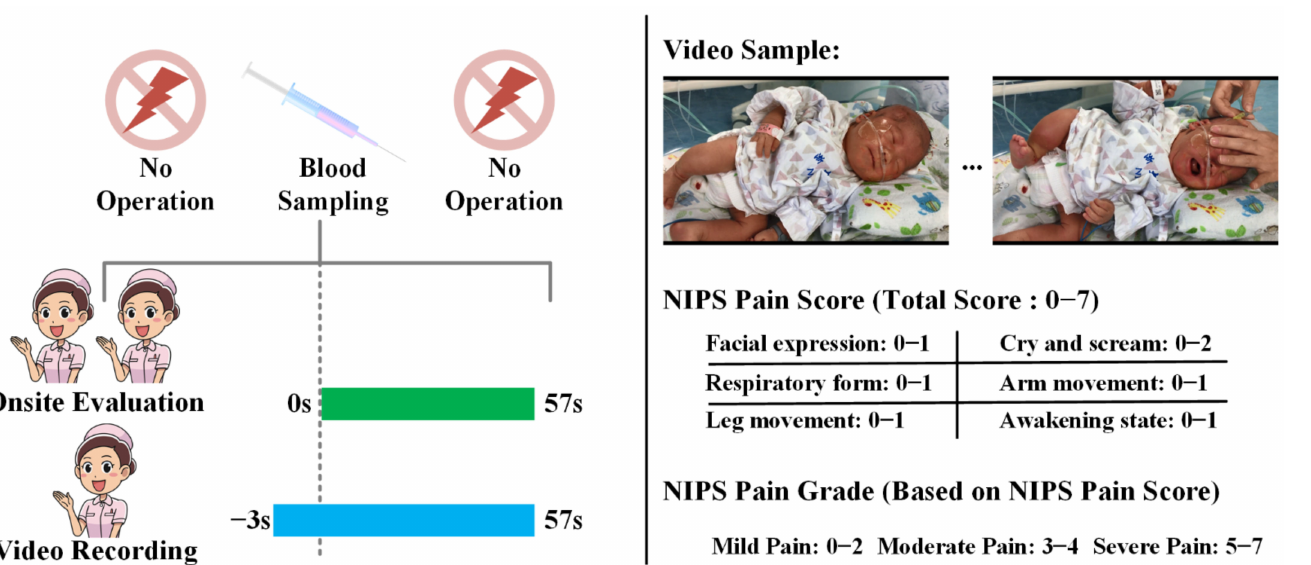
Figure 1. The study design of the clinical practicability of automated NPA